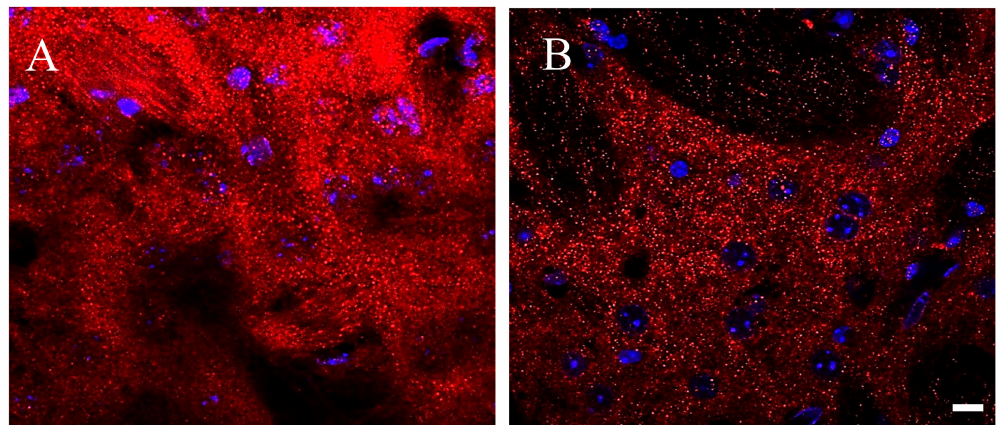
Figure 3. Representative immune-fluorescence microphotographs of confocal laser scanning microscopy (63×), double-labeled for D2 receptors and for nuclei in the striatum of control Tor1a+/+ ( A ), and of mutant Tor1a+/ − knock-out ( B ) mice. D2 receptor immune-labeling is visualized in red-Cy3 fluorescence, while nuclei are visualized by DAPI fluorescence in blue. Bar in B = 10 µm.